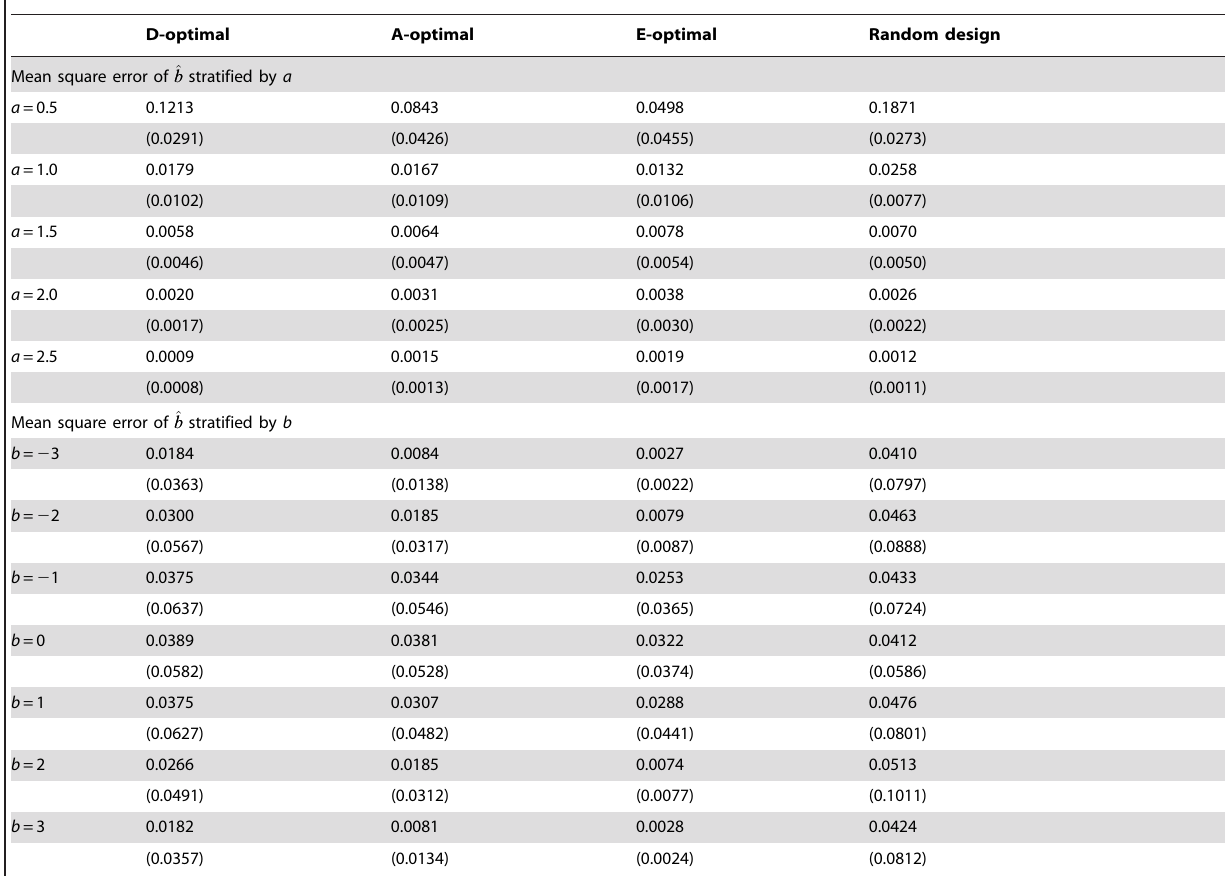
Table 3. Mean square error of ^ bb